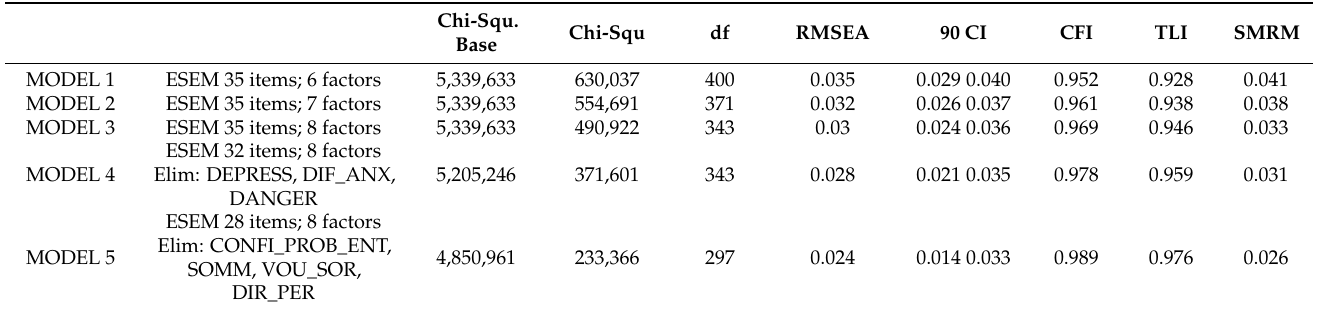
Table 1. ESEM models and indicators. Chi-Squ. Chi-Squ Base